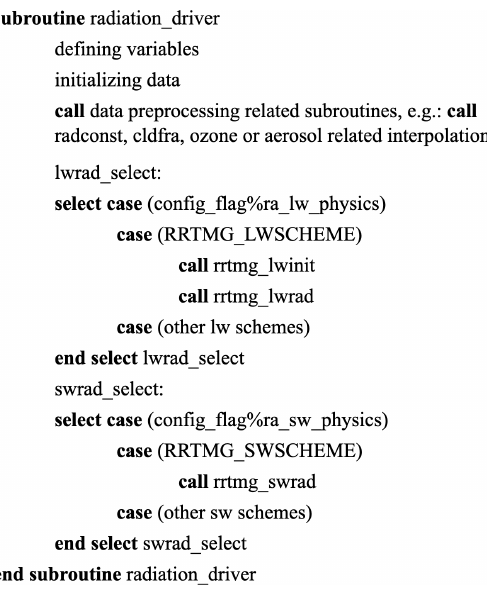
Figure 1. Pseudo-code for the original RRTMG module.